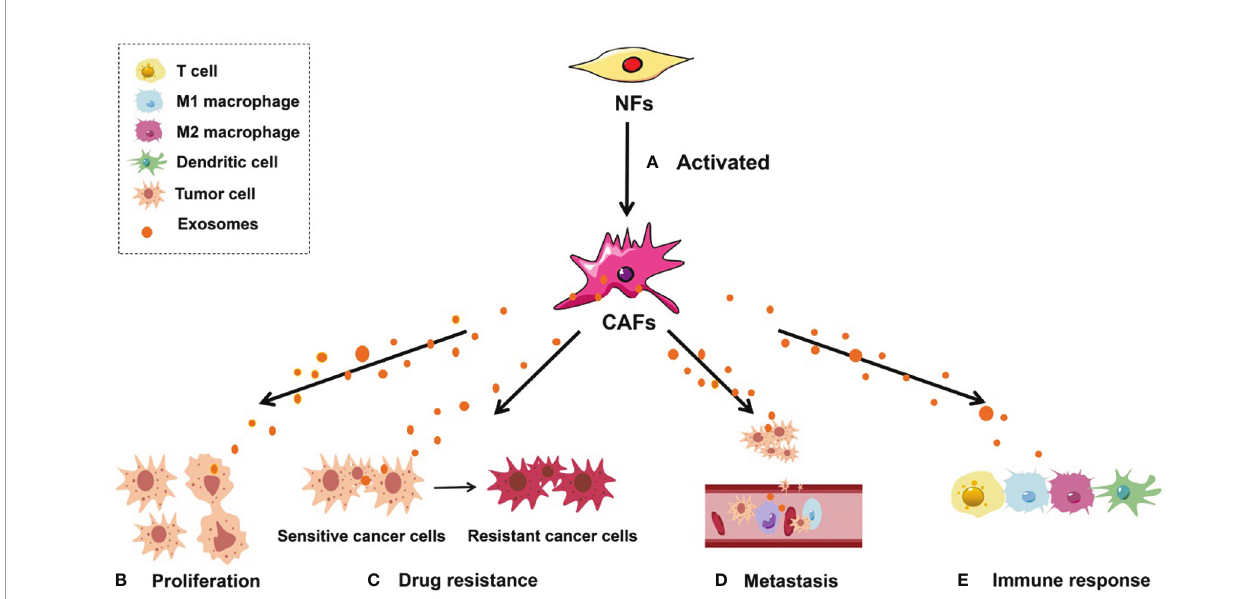
FIGURE 1 | Roles of CAF-derived exosomes in tumorigenesis. (A) Activated NFs can be converted into CAFs. (B) CAF-derived exosomes can regulate tumor cell proliferation; (C) CAF-derived exosomes can facilitate the conversion of drug-sensitive cancer cells into drug-resistant cancer cells; (D) CAF-derived exosomes are able to enhance the metastatic capacity of cancer cells; (E) CAF-derived exosomes can induce an antitumor immune response by regulating the activity of immune cells, including T cells, M1 macrophages, M2 macrophages, and dendritic